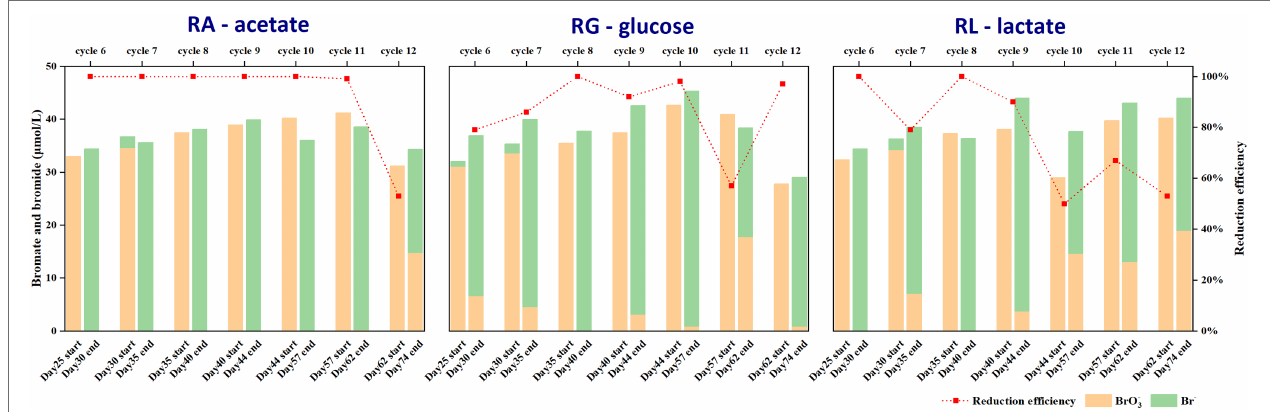
FIGURE 1 | Bromate reduction rates from cycle 6 to cycle 12 in three anaerobic microbial reactors by using acetate (RA), glucose (RG), and lactate (RL) as carbon sources. The percentage of bromate reduction in the first 5 cycles was